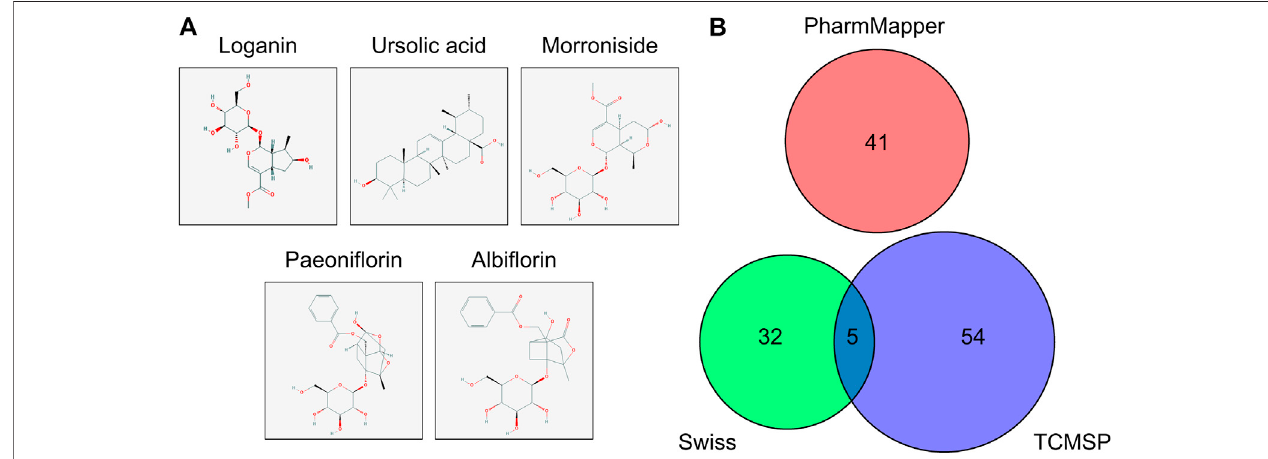
FIGURE 1 | Molecular structure and potential targets of the active compounds of Cornus of fi cinalis and Paeonia lacti fl ora. (A) Three active compounds of Cornus of fi cinalis(loganin,ursolicacid,andmorroniside)andtwoofPaeonialacti fl ora(paeoni fl orinandalbi fl orin)wereexaminedinthisstudy. (B) Intotal,132targetgenesamong the fi ve active compounds were identi fi ed by three databases (Swiss, TCMSP, and PharmMapper), with fi ve targets overlapping between Swiss and PharmMapper. However, no target gene was commonly identi fi ed by all three databases.